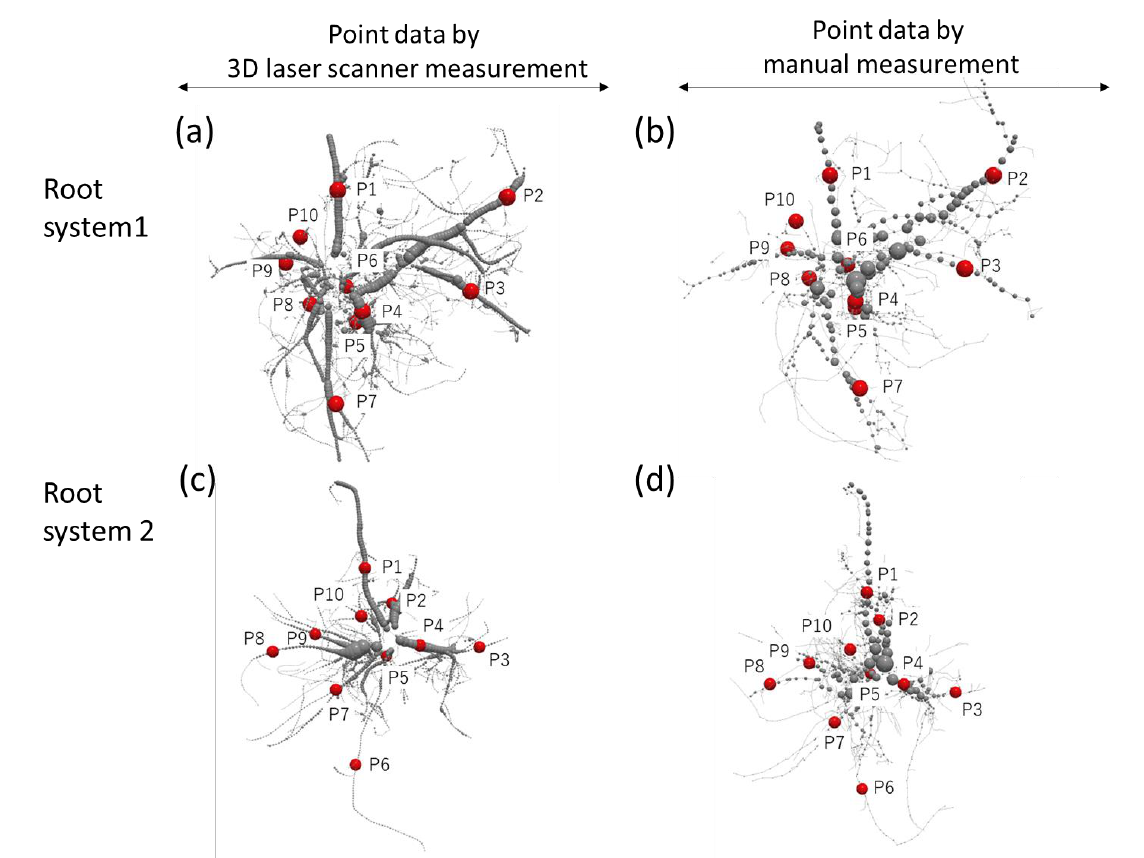
Figure 5. Positions of 10 points (P1–P10) set to evaluate the accuracy of the xyz coordinates and root diameters in root point data collected in ( a , b ) Root system 1 and ( c , d ) Root system 2 by ( a , c ) 3D laser scanner and ( b , d ) hand.